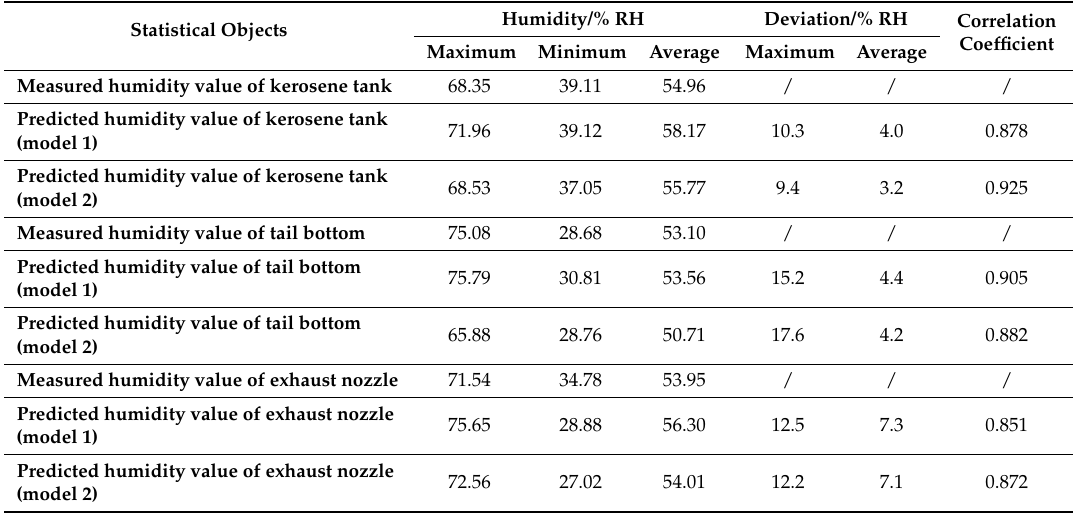
Table 3. Statistics of measured and predicted humidity